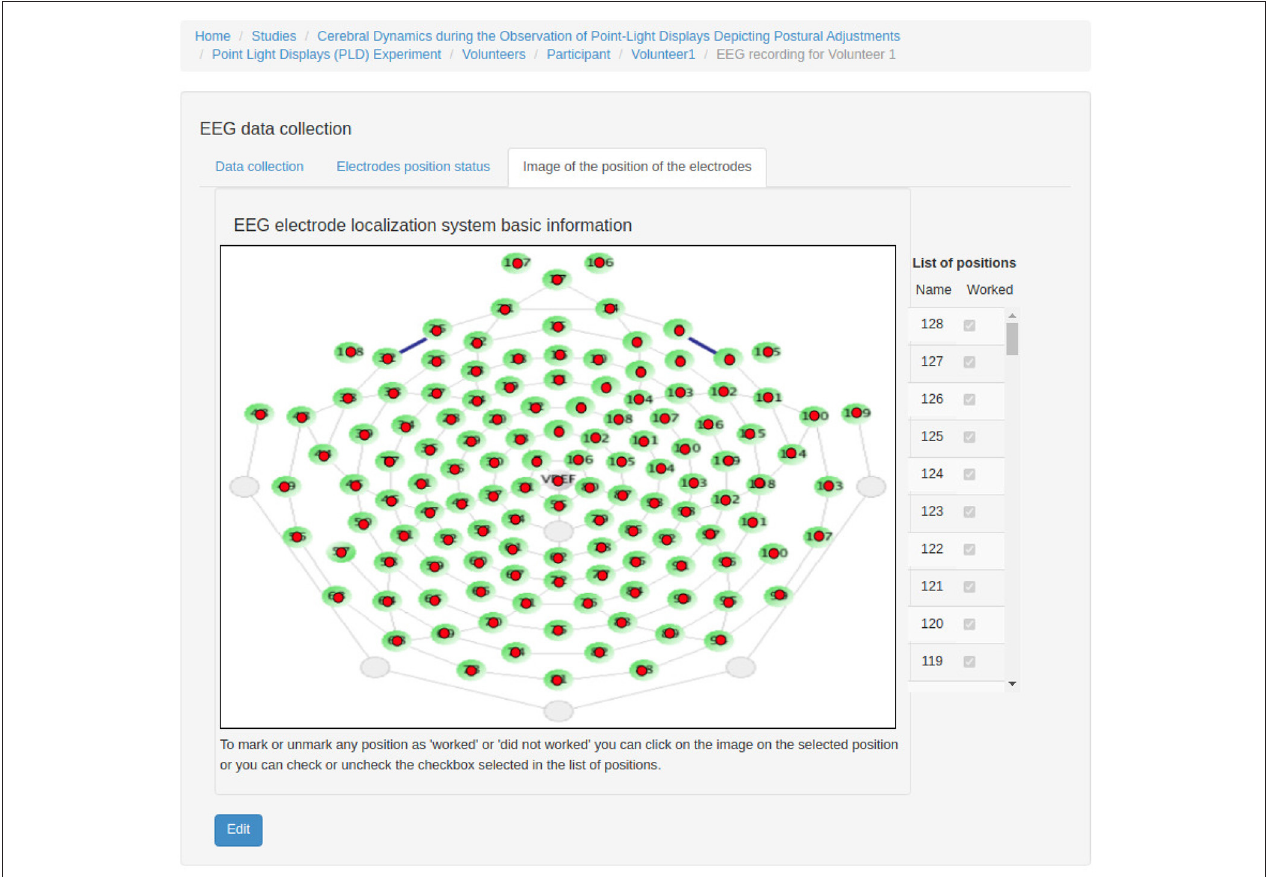
FIGURE 11 | NES graphical interface for registering electrode status in EEG data